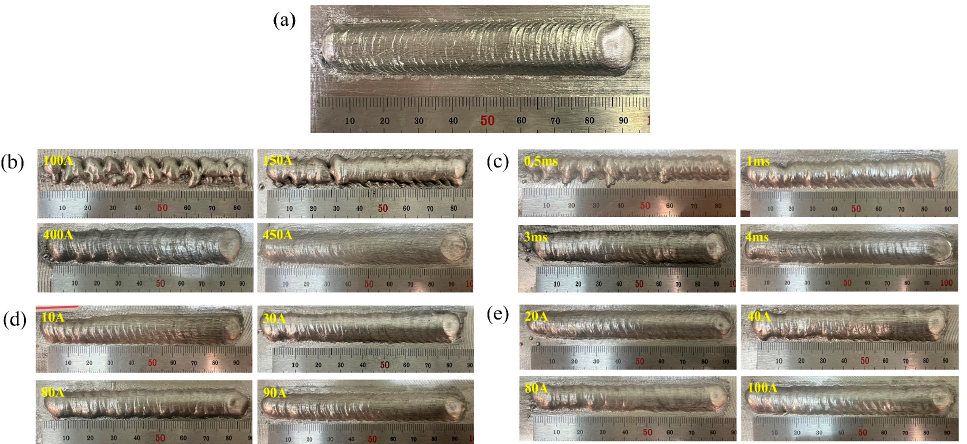
Figure 6. Appearance of the deposited layers: ( a ) Sample number 1; ( b ) Samples number 2–5; ( c )